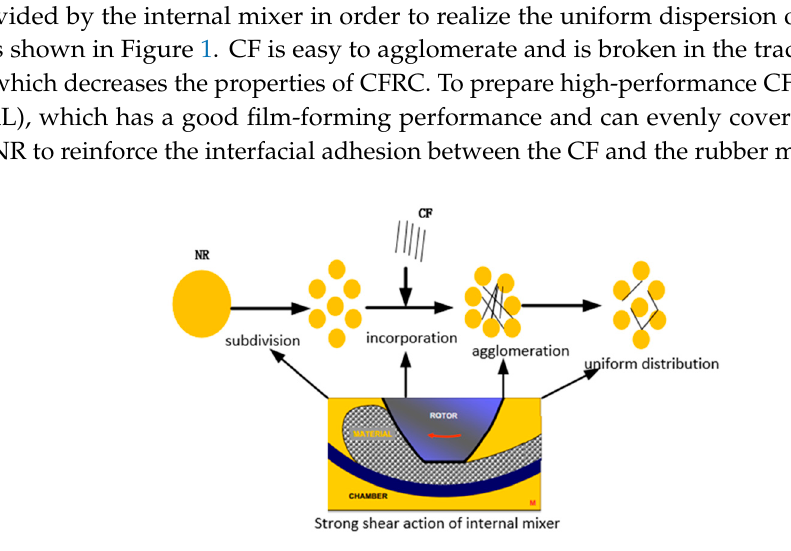
Figure 1. The processing of carbon fiber-reinforced rubber composites (CFRCs).